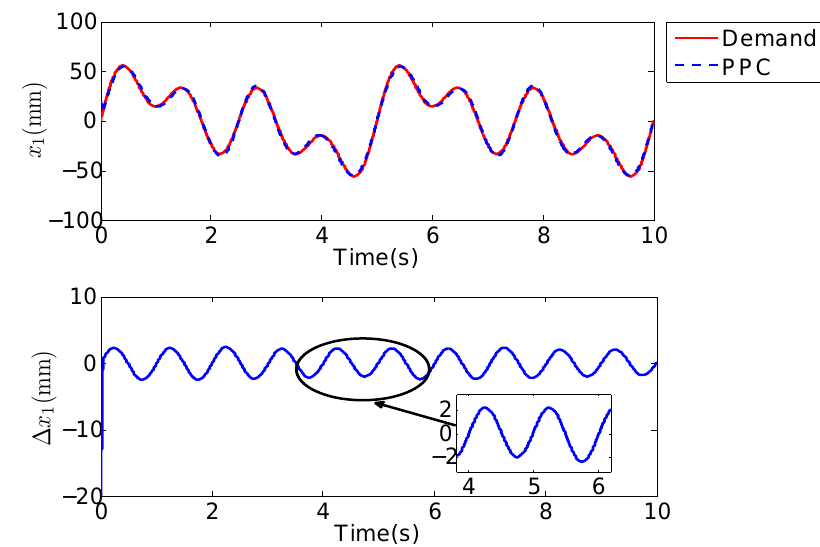
Figure 10. The cylinder position responses x 1 by prescribed performance constraint controller with hydraulic parametric uncertainties and the external load, the demand y d = 25 ( sin ( 1.6 π t ) + sin ( 0.8 π t ) + sin ( 0.4 π t ))